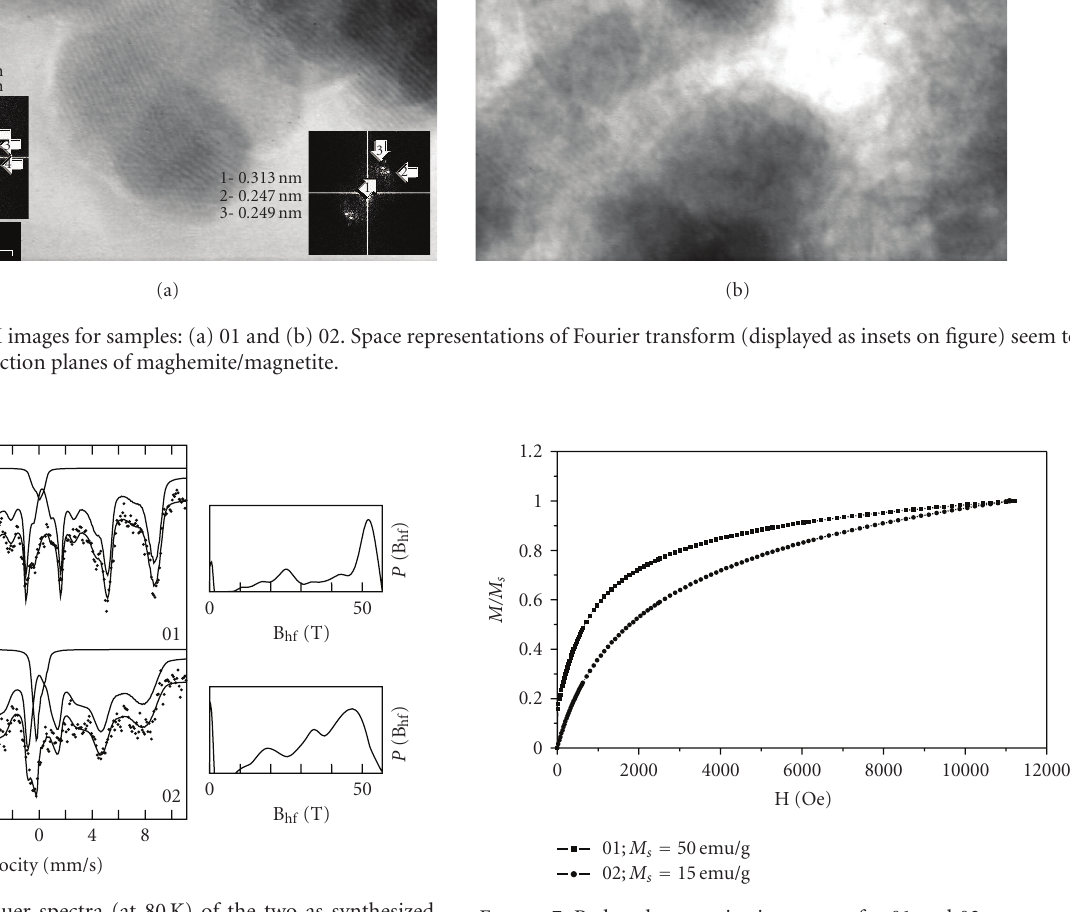
Figure 7: Reduced magnetization curves for 01 and 02 nanopow-